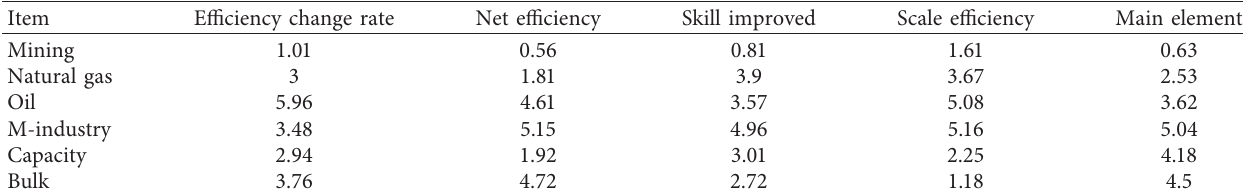
Table 8: The index is based on the rate of change of technical performance.